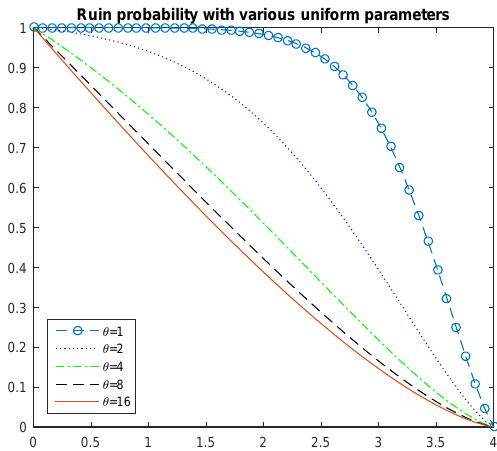
Figure 2. Ruin probabilities for Uniform [ 0, θ ] gains for θ =